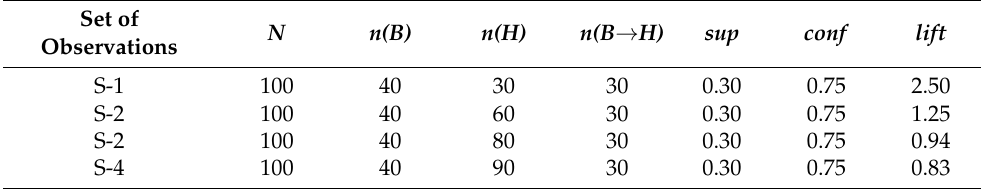
Table 4. The exemplary data sets with different lifts.